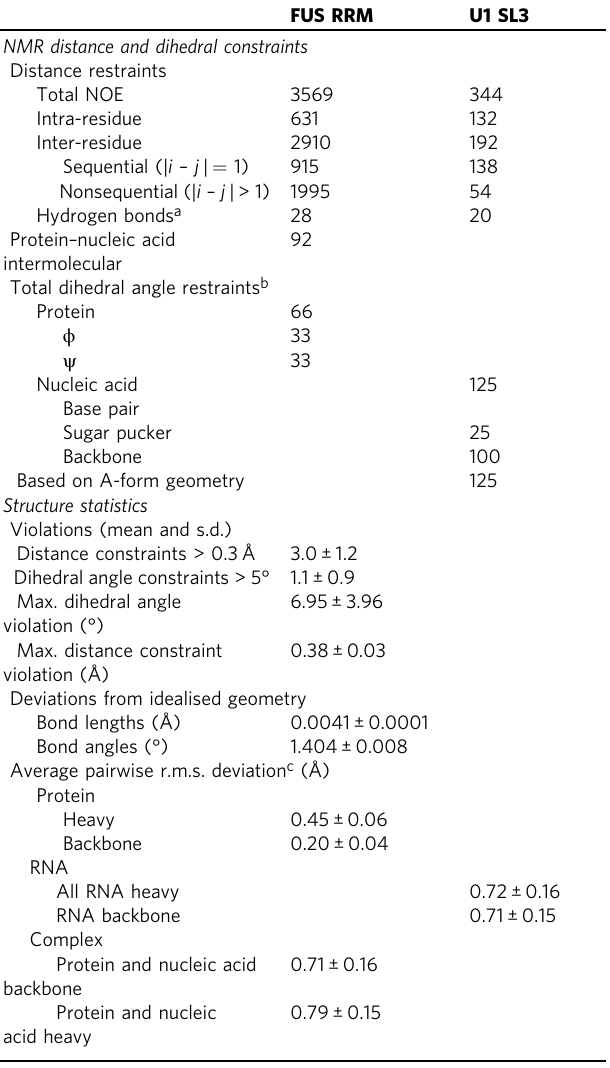
Table 1 NMR ensemble statistics of FUS: U1 SL3